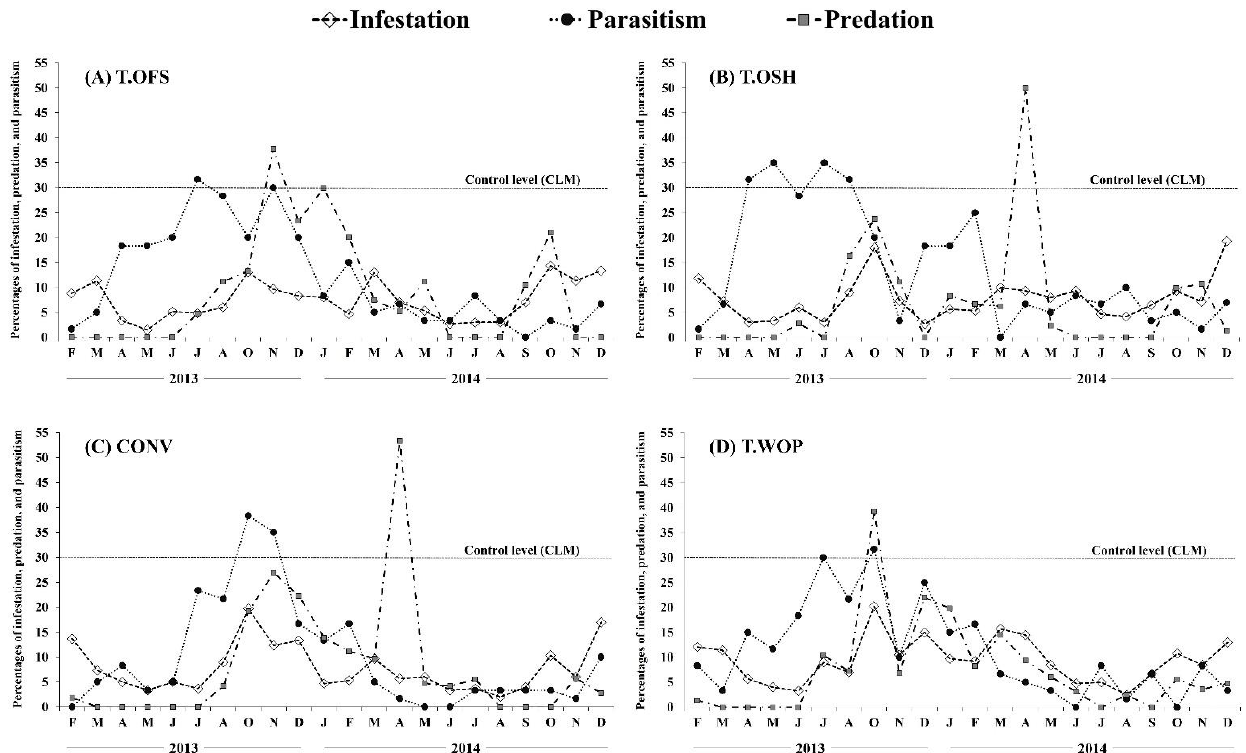
Figure 3. Variation in the percentages of infestation, predation, and parasitism of the coffee leaf miner, relative to the control level, in the conventional system (CONV) and the systems in transition to organic shaded (T.OSH), organic full-sun (T.OFS), and without pesticide (T.WOP). Campo do Meio and Guapé, MG, Brazil, February 2013 to December 2014.